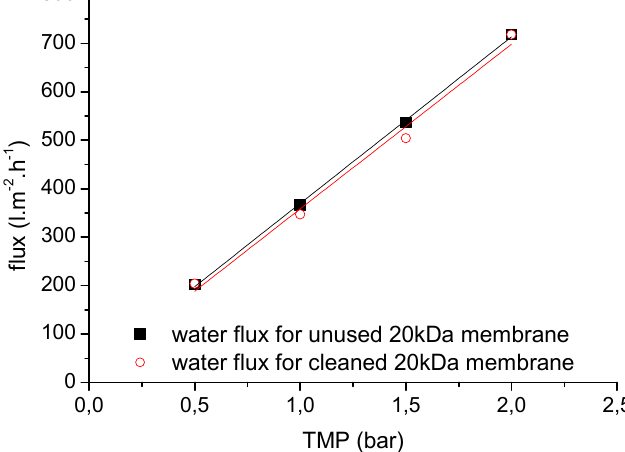
Figure 12. The clean water fluxes of unused and cleaned 20-kDa UF ceramic membranes at different TMPs (0.5–2.0 bar) and a temperature of 25 °C.